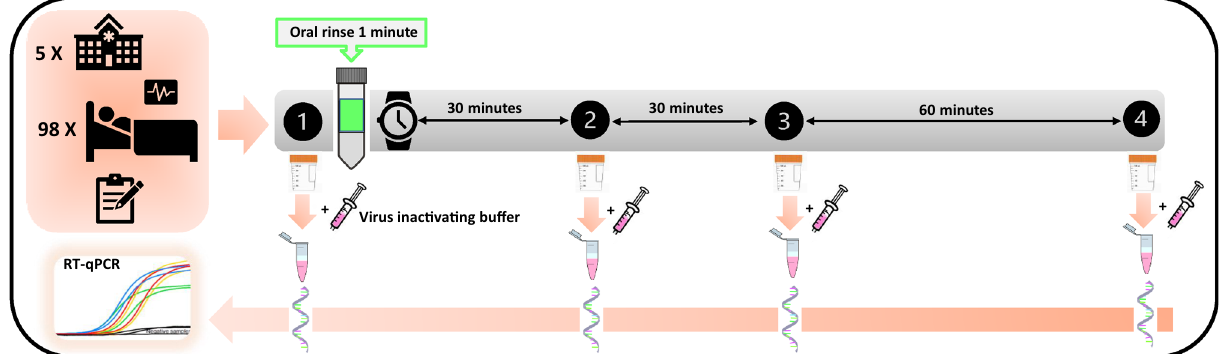
Figure 1. Diagram of the experimental study protocol. The upper left panel illustrates the multicentre study with five hospitals involved, the number of enrolled patients diagnosed and hospitalized because of SARS- COV-2 infection and the record of clinical variables. The sampling of the four non stimulated saliva samples for each patient is represented by the numbers 1, 2, 3 and 4 (corresponding to one basal and three post-mouthwash samples, at 30 min, at 60 min and at 120 min, respectively), as well as the rinsing time for 1 min. In this blind study, participants were randomly assigned to one of the five parallel group: PVP-I (group A), H 2 O 2 (group B), CPC (group C), CHX (group D) and distilled water (group E, control group). After each sampling, 0.5 mL of saliva was transferred to a sterile Eppendorf tube with 1.5 mL of virus inactivating buffer, illustrated in the figure with a syringe. All samples were taken to the laboratory where RNA extraction and RT-qPCR (reverse transcription—quantitative polymerase chain reaction) was